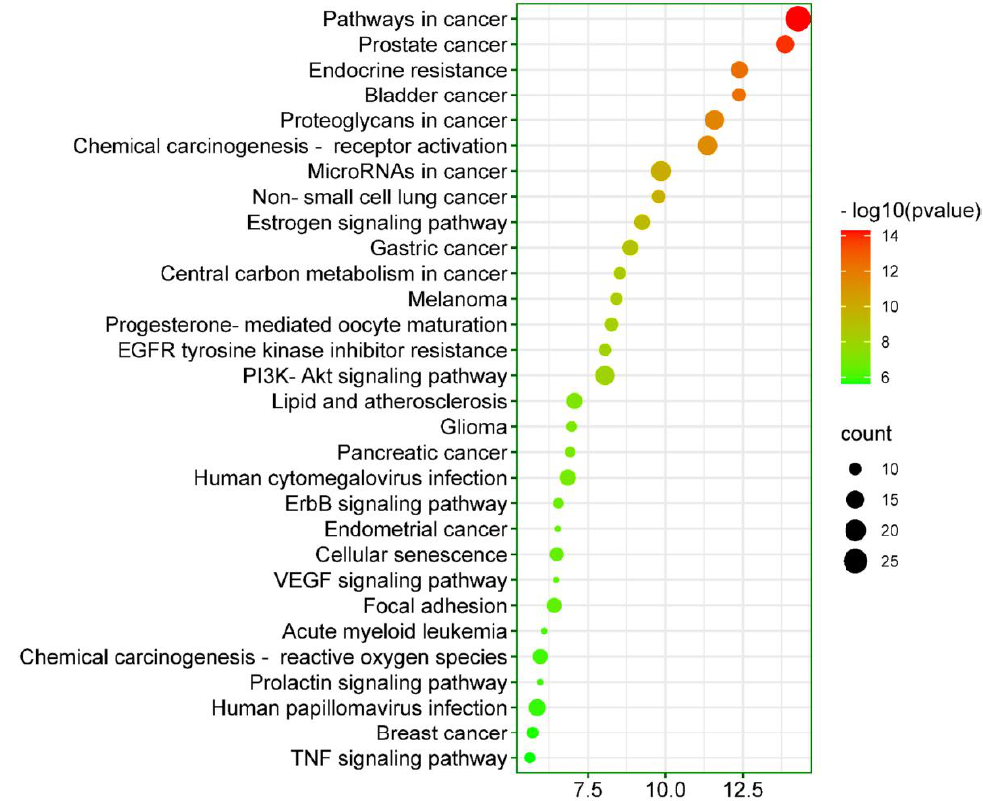
Figure 8. The top 30 enriched KEGG pathways of 67 intersecting targets involved in Cnidium monnieri ’s anti-HCC therapeutic effects. Table 2. Molecular docking results in terms of the binding energy of eight key active phytochemicals of Cnidium monnieri with six anti-HCC core